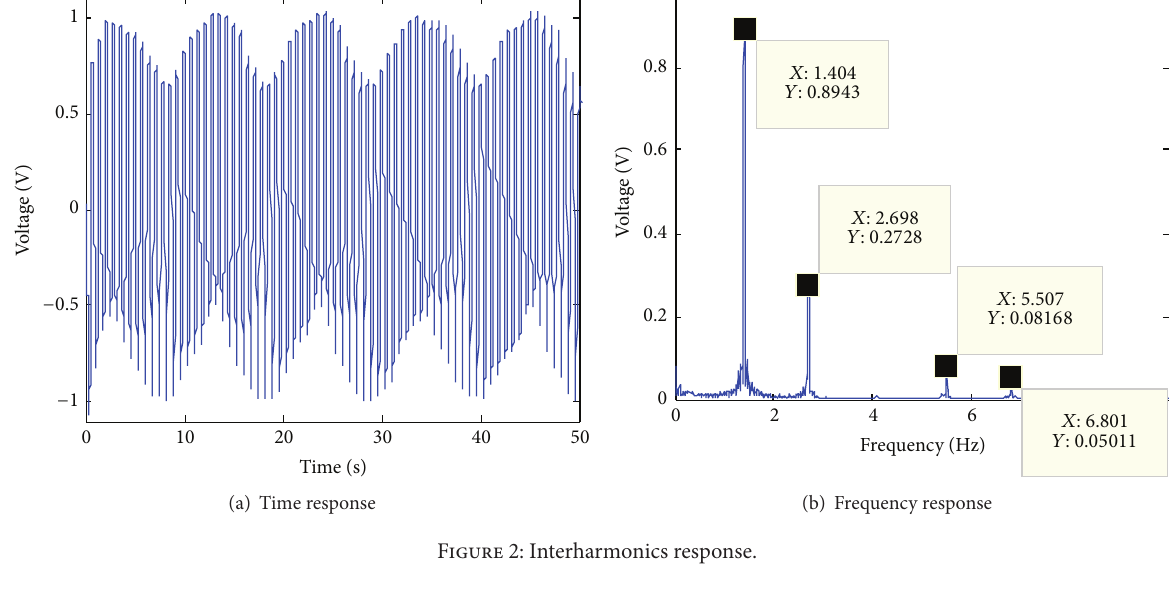
Figure 2: Interharmonics response.